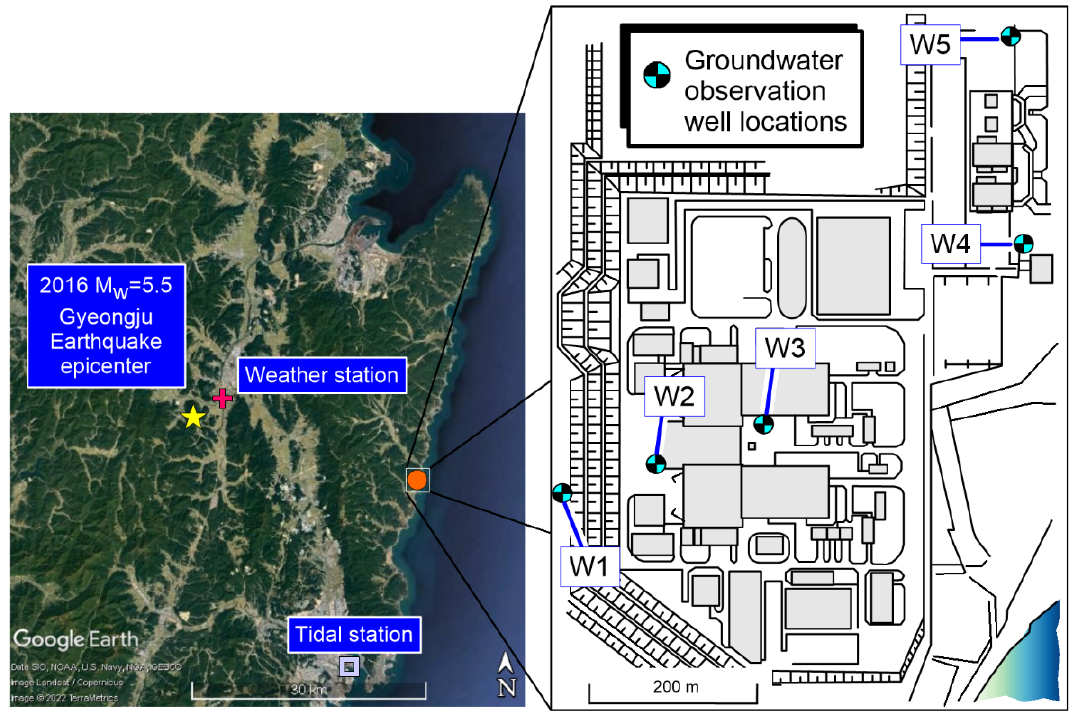
Figure 2. Map showing the 2016 Gyeongju earthquake epicenter and the nearby power plant study site. The inset shows the locations of five groundwater observation wells within the power plant site.